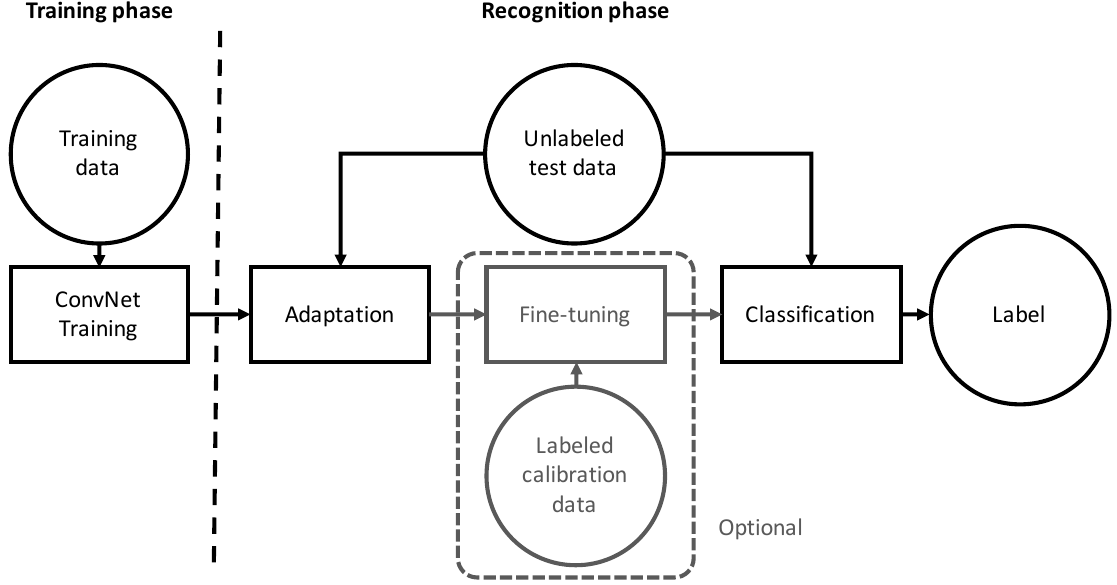
Figure 3. Gesture recognition based on deep domain adaptation. Fine-tuning is performed only when labeled calibration data are